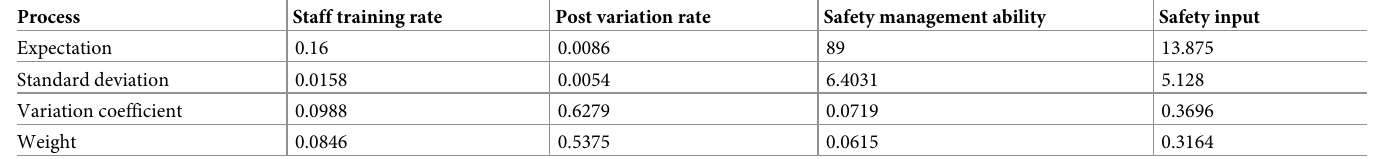
Table 2. Weight calculated with the variation coefficient